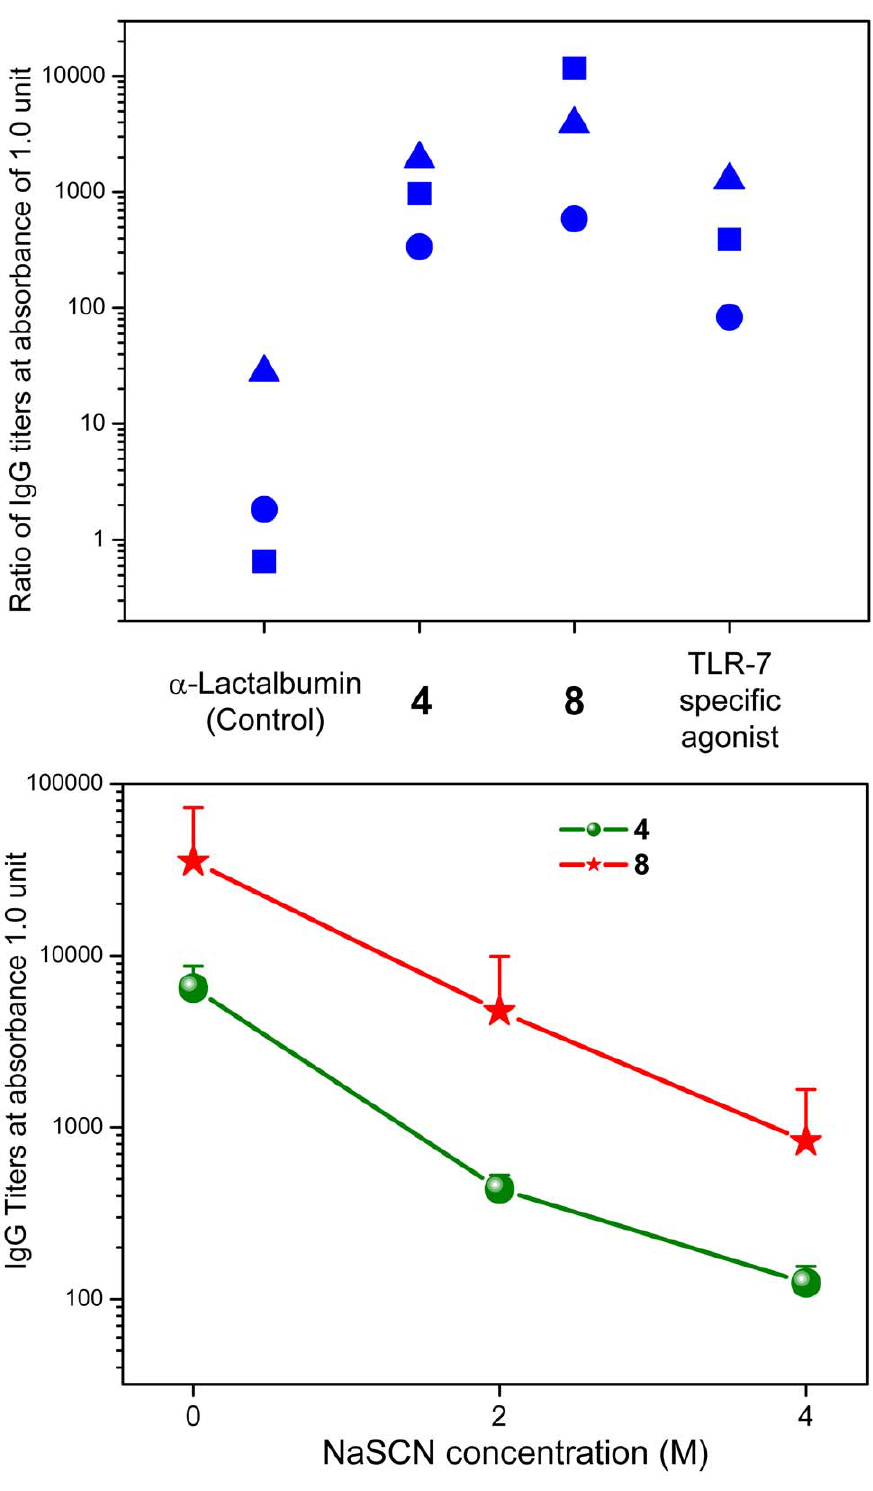
Figure 5. Anti-bovine a -lactalbumin-specific IgG titers. Top: Anti-bovine a -lactalbumin-specific IgG titers in rabbits adjuvanted with 4 , 8 , a TLR7-specific imidazoquinoline (1-benzyl-2-butyl-1 H -imidazo[4,5- c ]quinolin-4-amine; reported as Compound 31 in Ref. 9), and unadjuvanted controls (n=3 per cohort). Ratios of immune/pre-immune titers yielding absorbance values of 1.0 are shown for the individual samples. Each symbol corresponds to the titer of a single animal. Bottom: Chaotropic ELISA showing apparent titers as a function of chaotrope (NaSCN) concentration. Means and SD are shown.